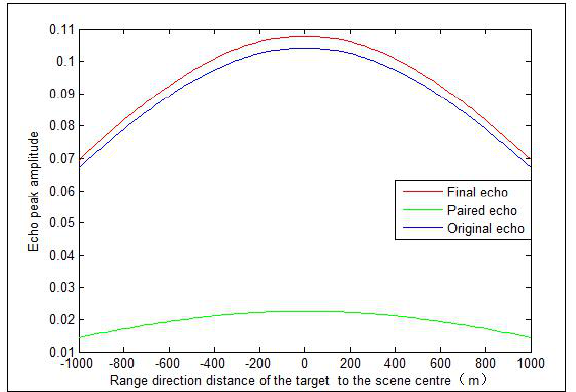
Figure 5. The influence of target range direction position to the echo peak